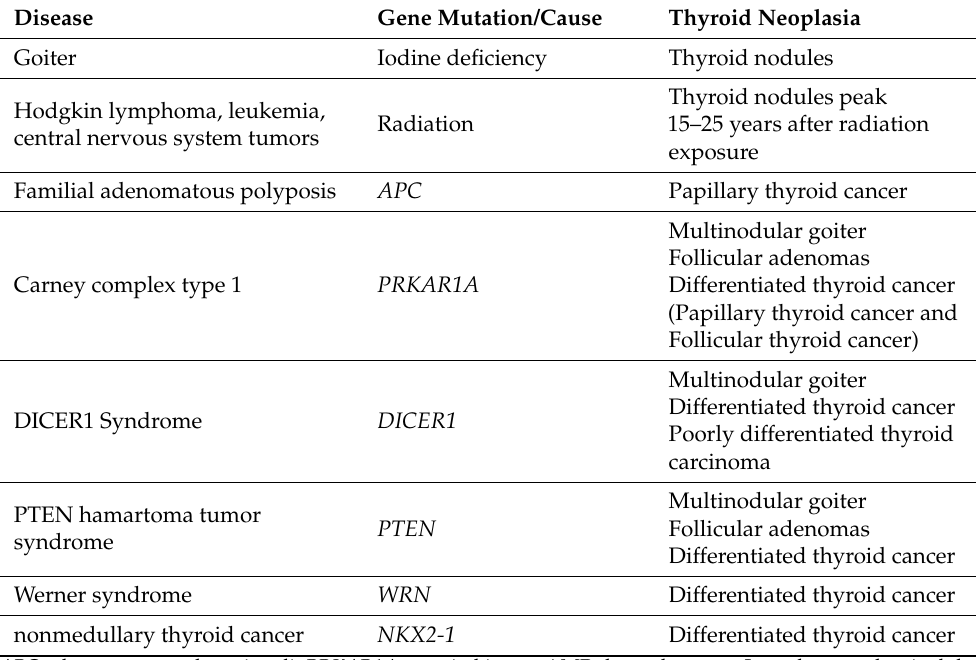
Table 2. Disorders associated with thyroid nodule